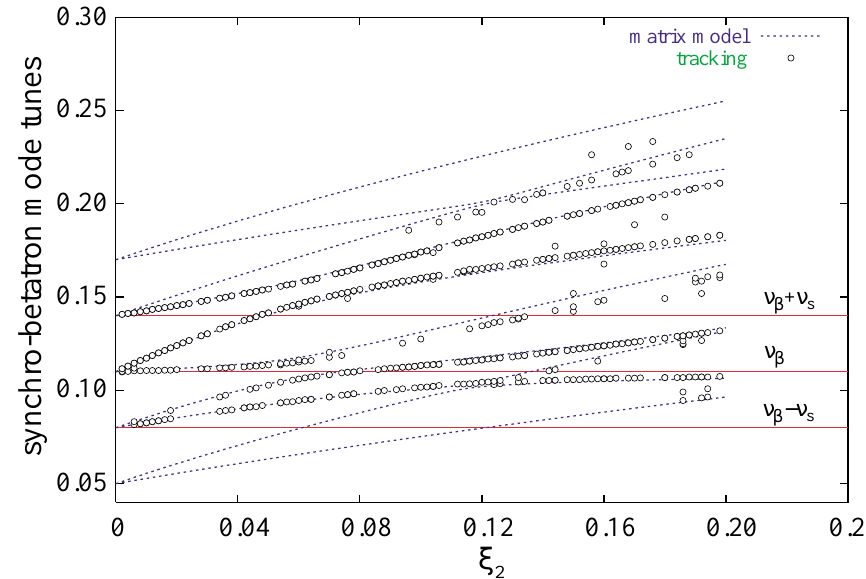
FIG. 5. (Color) Synchrobetatron mode tunes vs j 2 . Comparison of the circulant matrix model and tracking. Unequal bunch intensi- ties, j 1 (cid:2) j 2 (cid:1) 0.5 , n b (cid:1) 0.11 , n s (cid:1) 0.03 , and the bunch length is 0.7 b (cid:1) . when neither mode reaches the tune of 0 or 0.5. Interac- tion in this system is symmetrical, and the system is closed.